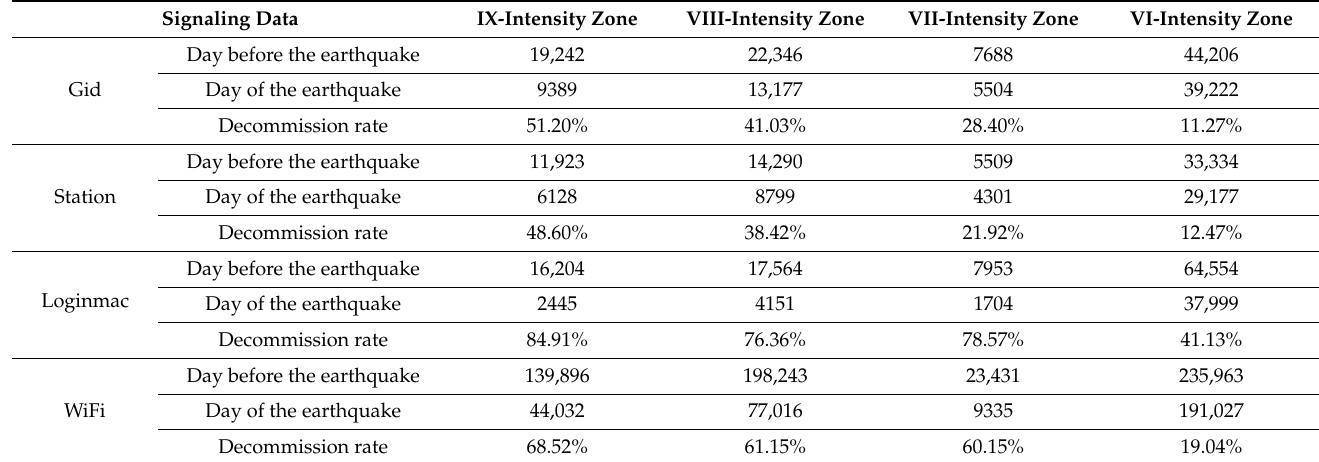
Table 4. Number of devices associated with the four indicators in different intensity